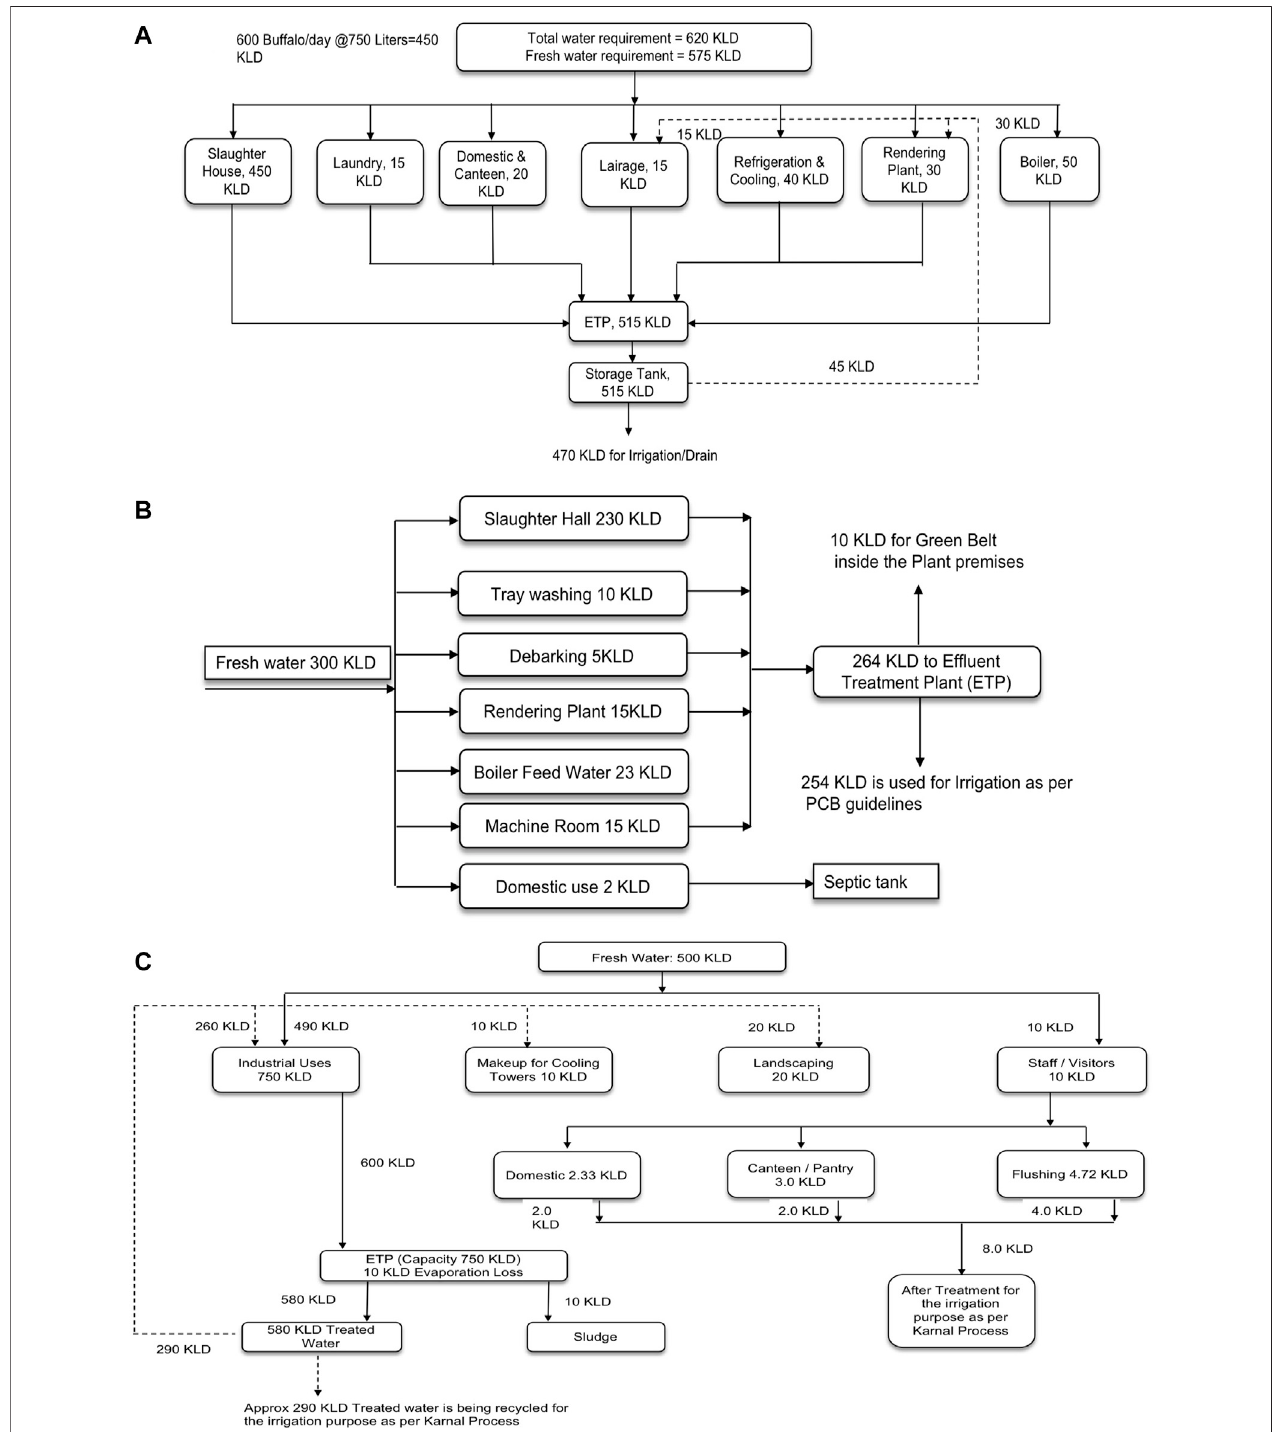
FIGURE 4 | Water balance of (A) Meem Agro, (B) Al Noor, and (C) Int. Agro Foods Pvt., Ltd.